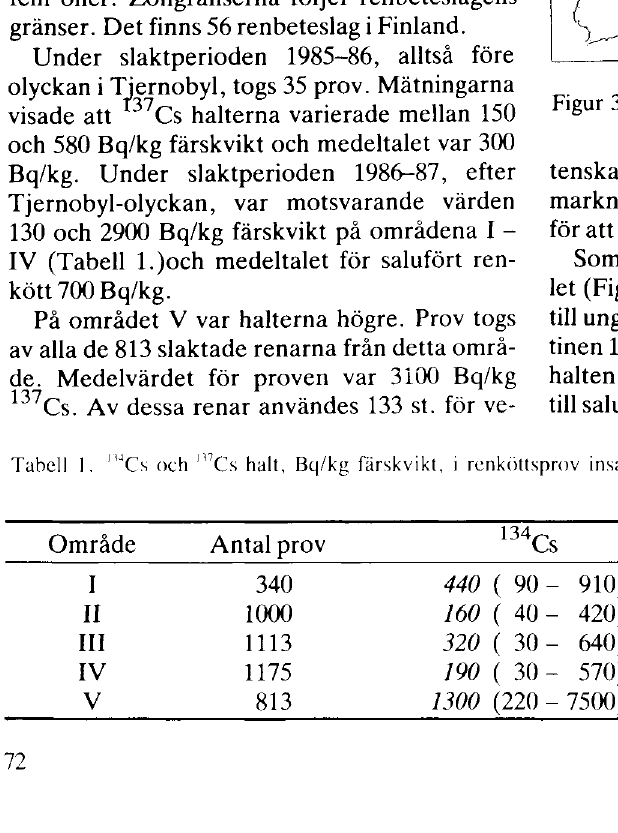
Figur 2. Renskotselområdet i Finland.